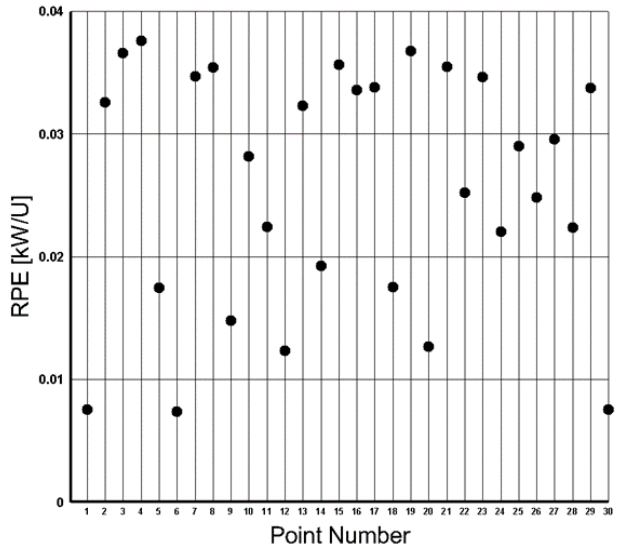
Figure 5. RPE for the optimal configurations of the Kerman power plant.